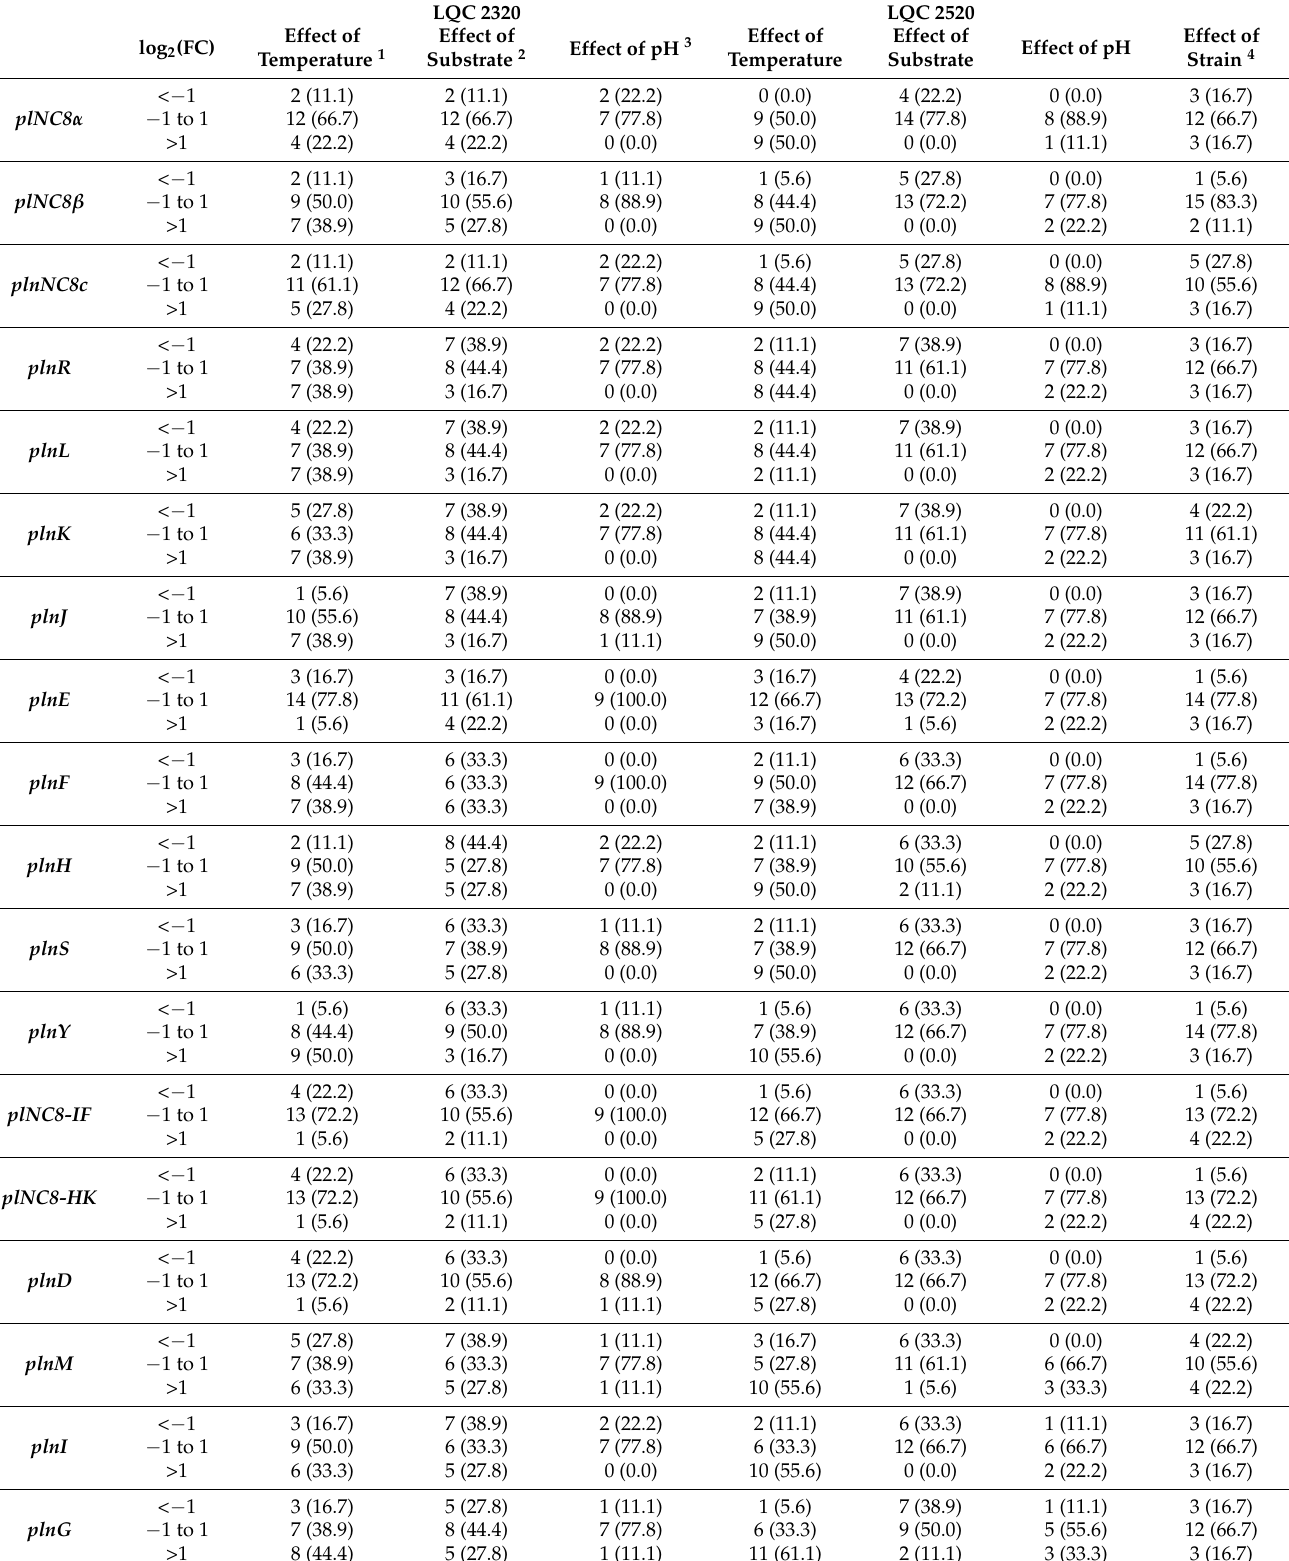
Table 2. Number of samples in which the relative transcription of the genes under study was below, above or within the threshold set under the effect of sourdough related parameters on Lp. plantarum strains LQC 2320 and LQC